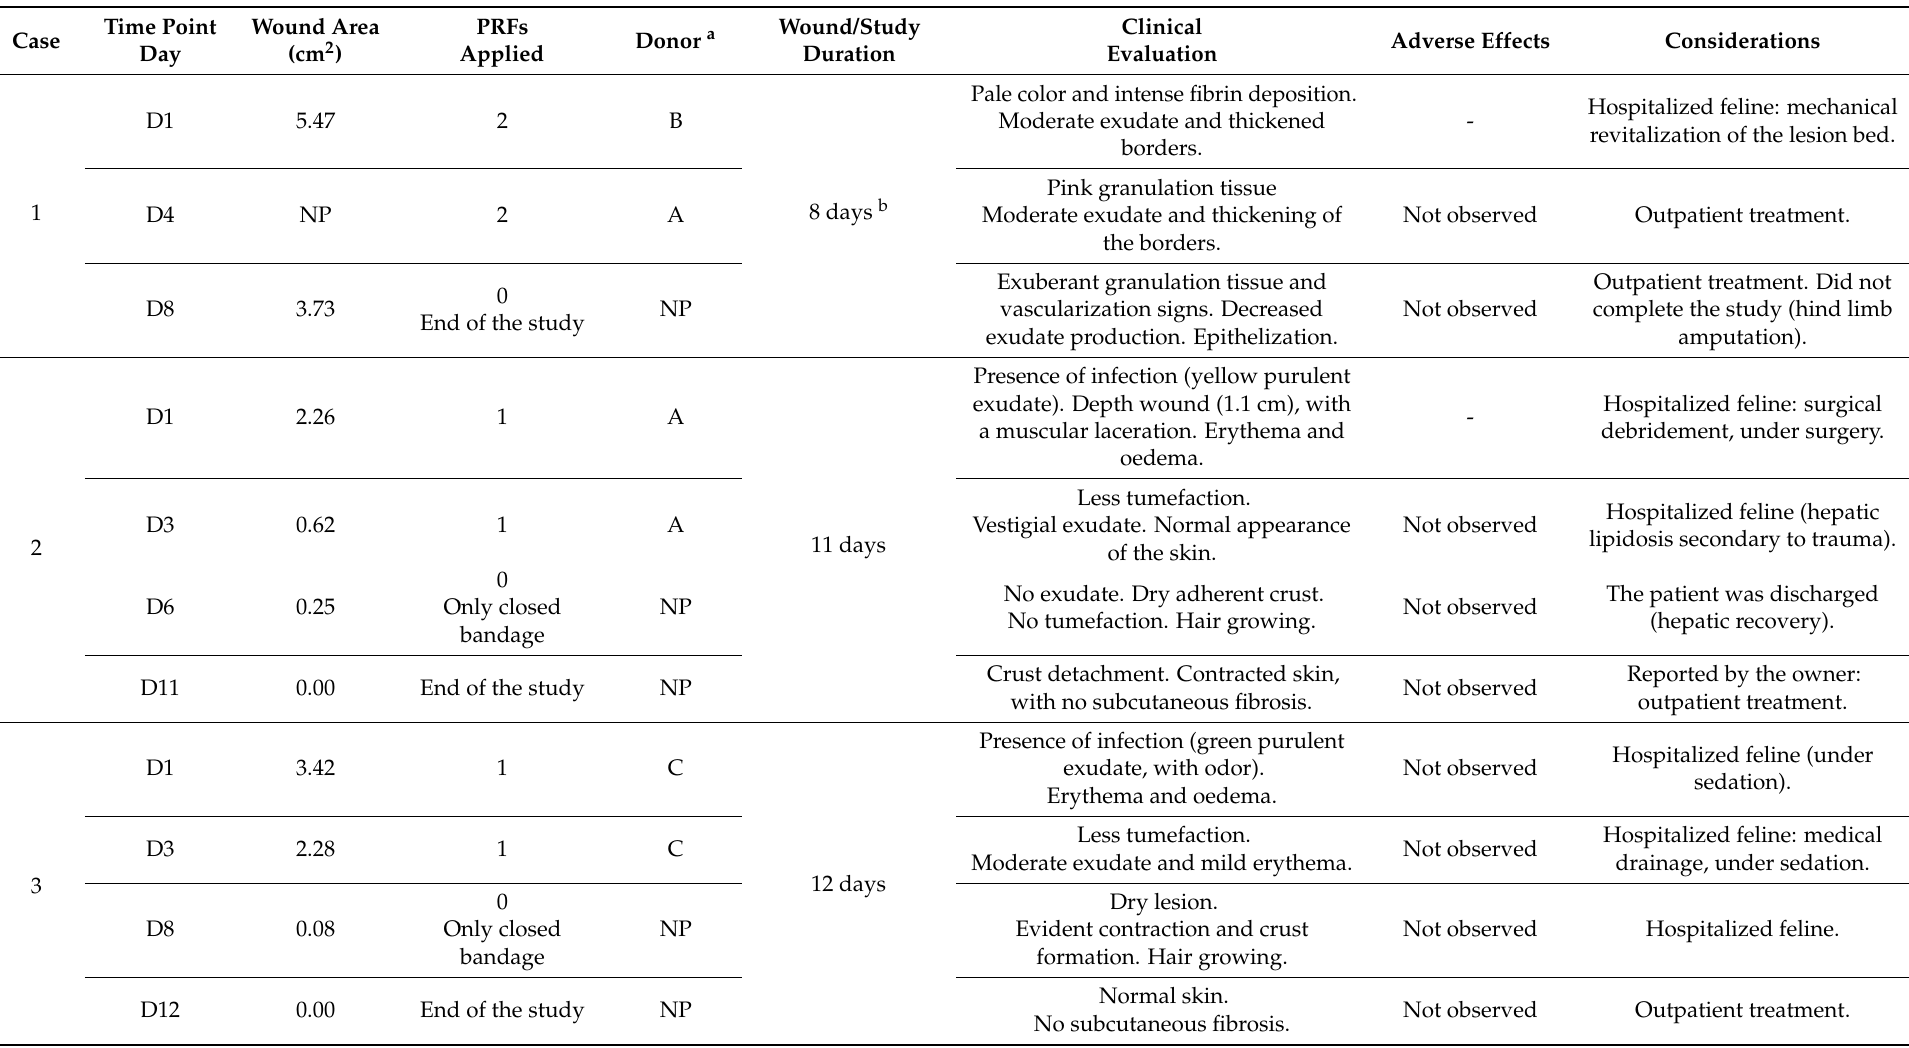
Table 3. Feline wound characterization and treatment protocol at the baseline, day 1